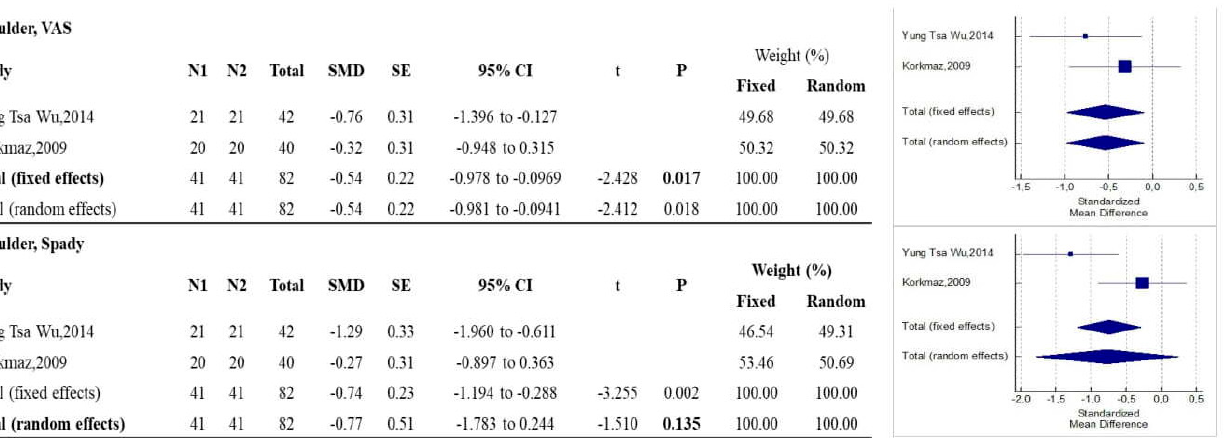
Figure 2. Forest plots showing the intervention effect on the shoulder VAS and Spady outcomes. The use of fixed or random effects (bold) is chosen based on the results of the Higgins’ heteroge- neity test. Note: N1= no. of patients in the intervention group; N2 = no. of patients in the control group; SMD = standardized mean difference; CI = confidence interval .